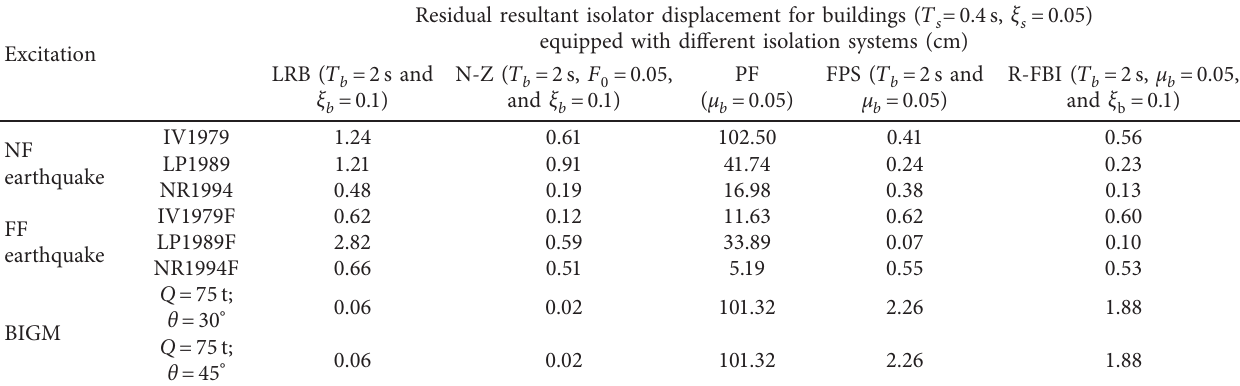
Table 3: Residual resultant isolator displacements of four-story base-isolated buildings under NF earthquakes, FF earthquakes, and BIGMs.